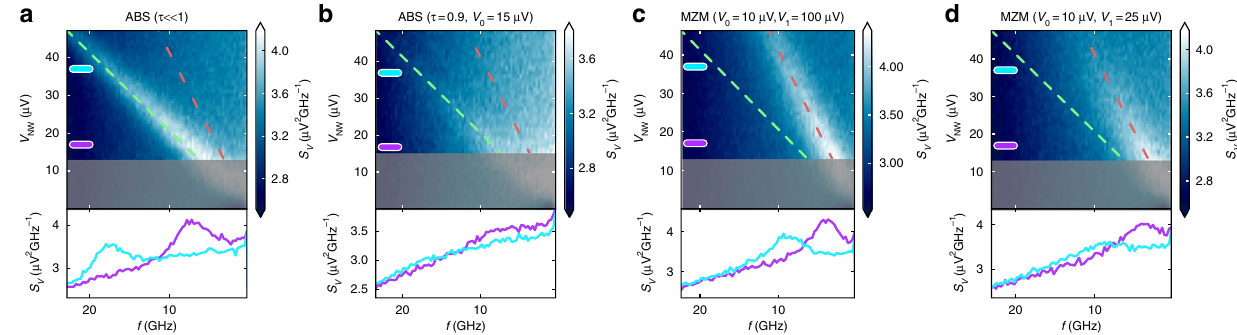
Fig. 4 The calculated radiation spectrum. The voltage spectral density S V ( f ) incident on the detector junction, computed by numerically solving the system of stochastic differential equations shown in Supplementary Note 3. a , b Show results for a junction in the trivial regime (small transmission and large transmission, respectively), while ( c , d ) show the emission spectrum in the topological regime. V 0 and V 1 are voltage scales for Landau – Zener tunneling between branches of the junction bound state and for tunneling to the quasiparticle continuum, respectively; see text. Circuit parameters are set ¼ 8 nA. The noise temperature T = 150 mK and the quasiparticle poisoning as r NW = 2.4 k Ω , R NW = 50 k Ω , R = 0.5 k Ω , C = 10 fF, C C = 400 fF, and I 0 NW rate is Γ q = 100 MHz. As in Fig. 2, the dashed green and red lines show the frequency of Josephson radiation corresponding to e * = 2 e and e * = e , respectively. The estimated phase-diffusion region is shaded